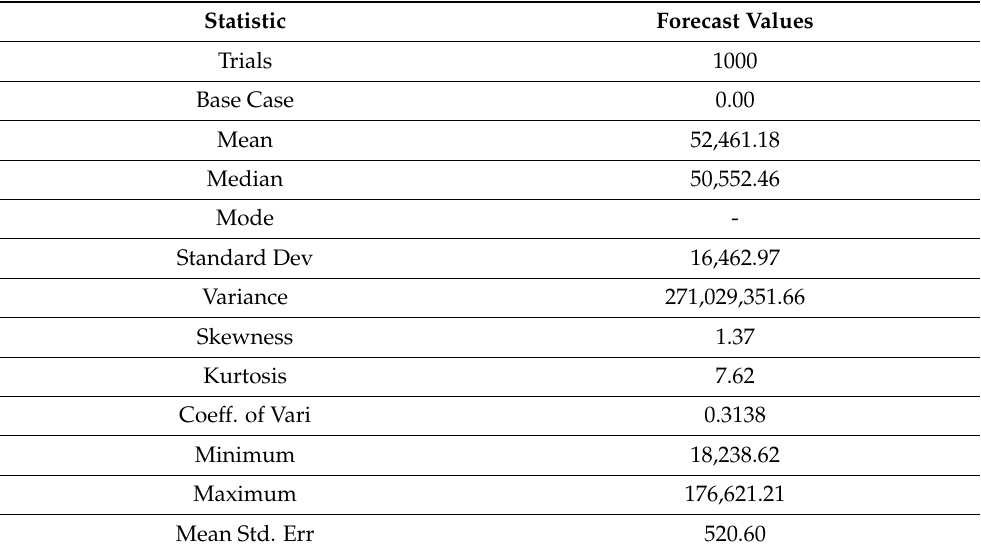
Table 10. Description statistics of the probability distribution of present values of incomes from accommodation rental facilities in Košice for 10 years.